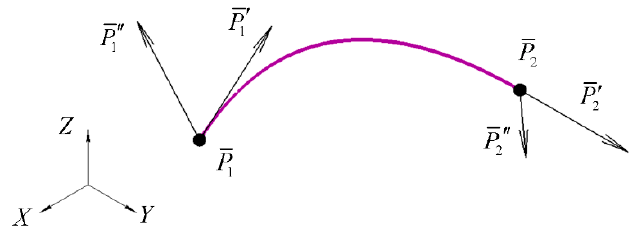
Figure 3. Hermitian fifth-degree segment.